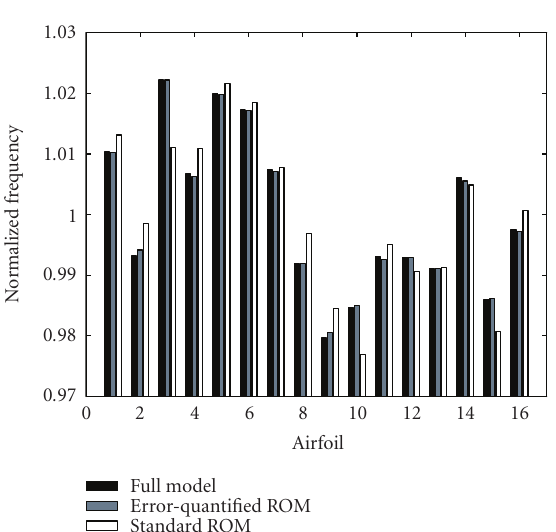
Figure 5: Frequency prediction comparison (Mode